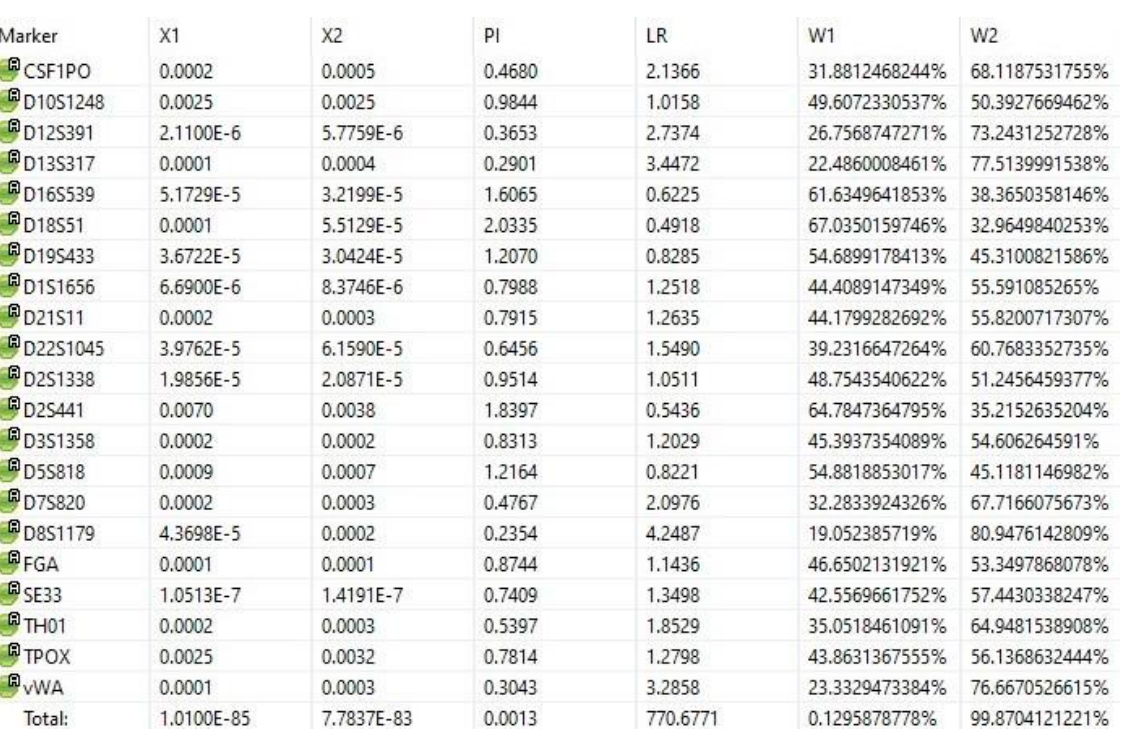
Figure 3. Screenshot of the results of statistical calculations for Hypothesis I, performed in GenoEvidence 3. Table 2. Results of the Y-STR haplotype concordance study between NN male and nephews of Michal